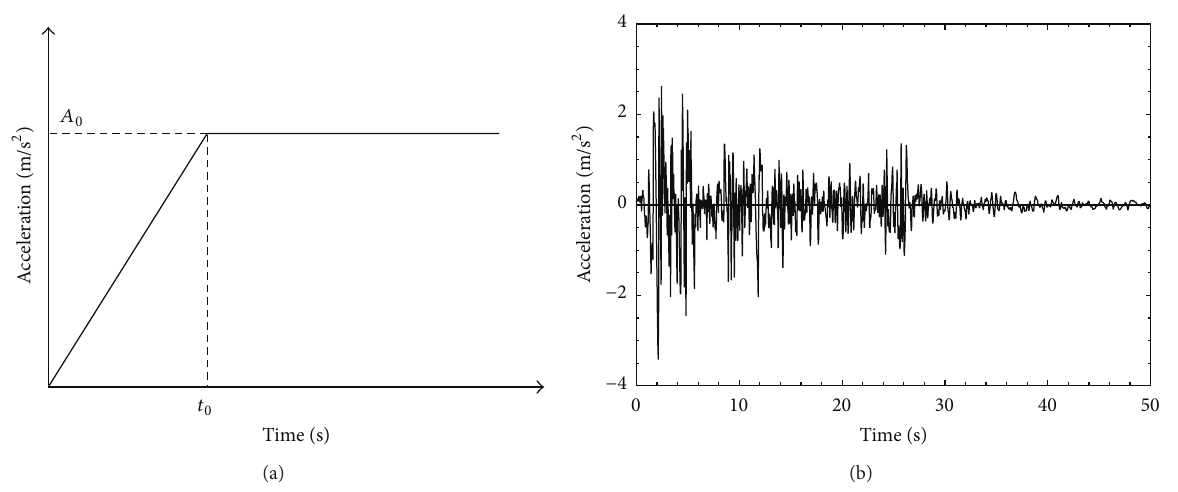
Figure 2: (a) Ideal turning movement, (b) El Centro 1940